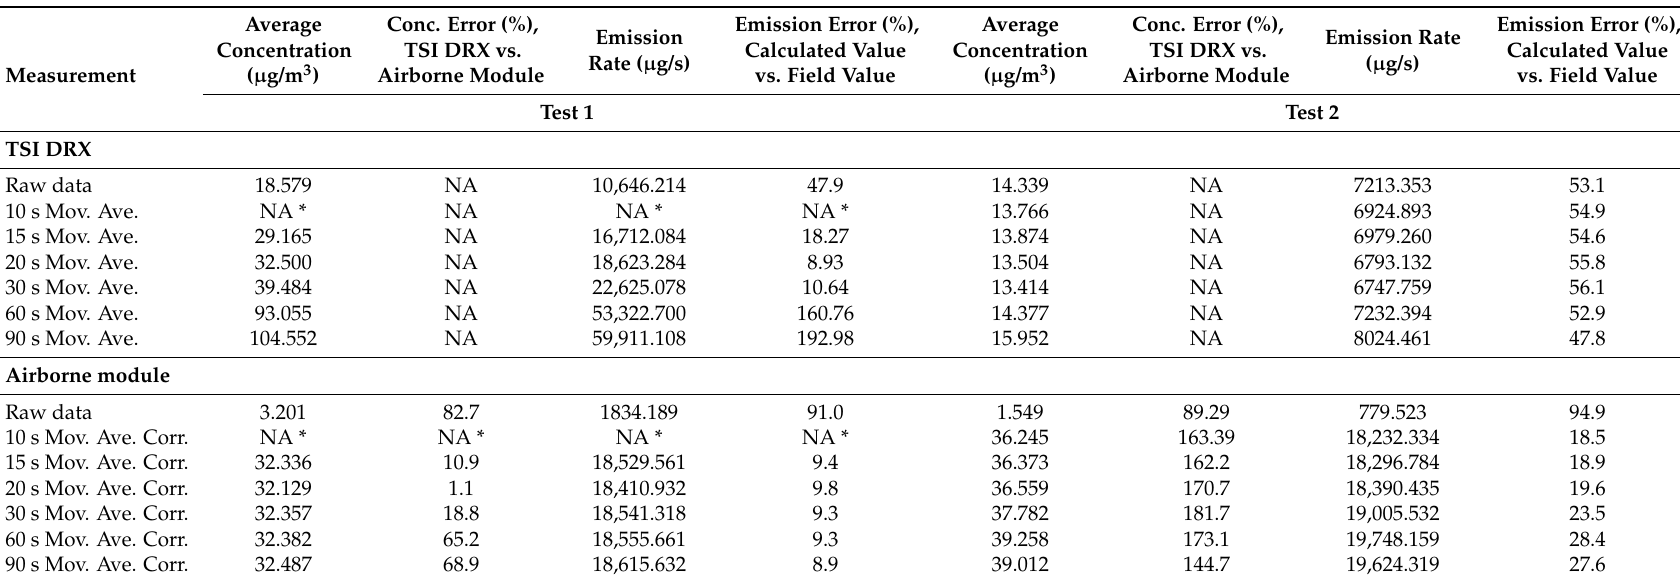
Table 8. Summary of concentrations and emission rates calculated for Tests 1 and 2 with their percentage